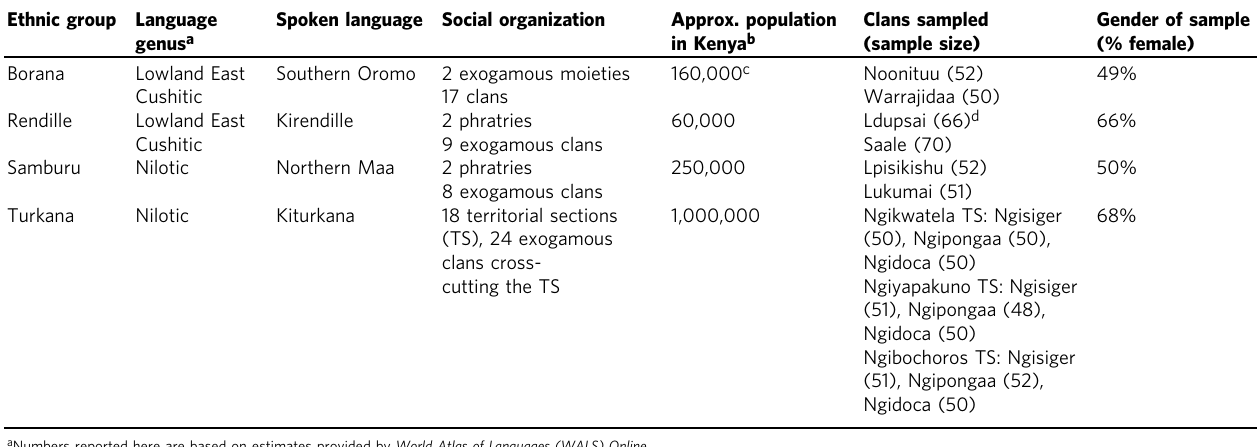
Table 1 Study populations and sample size.